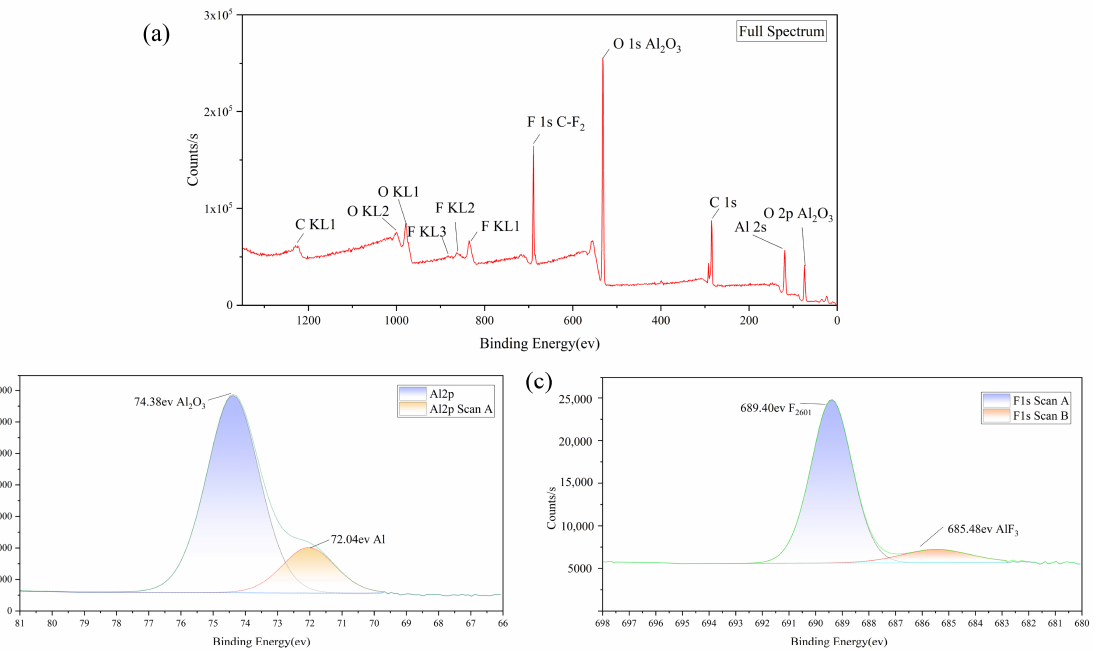
Figure 6. P – t profiles of samples at a constant volume of 330 mL . Laser ignition testing is commonly used to characterize the combustion performance of metal powders, and is generally judged by the ignition delay time, radiation intensity, and burning time [26–28]. The laser ignition schematic is shown in Figure 7. The mass of